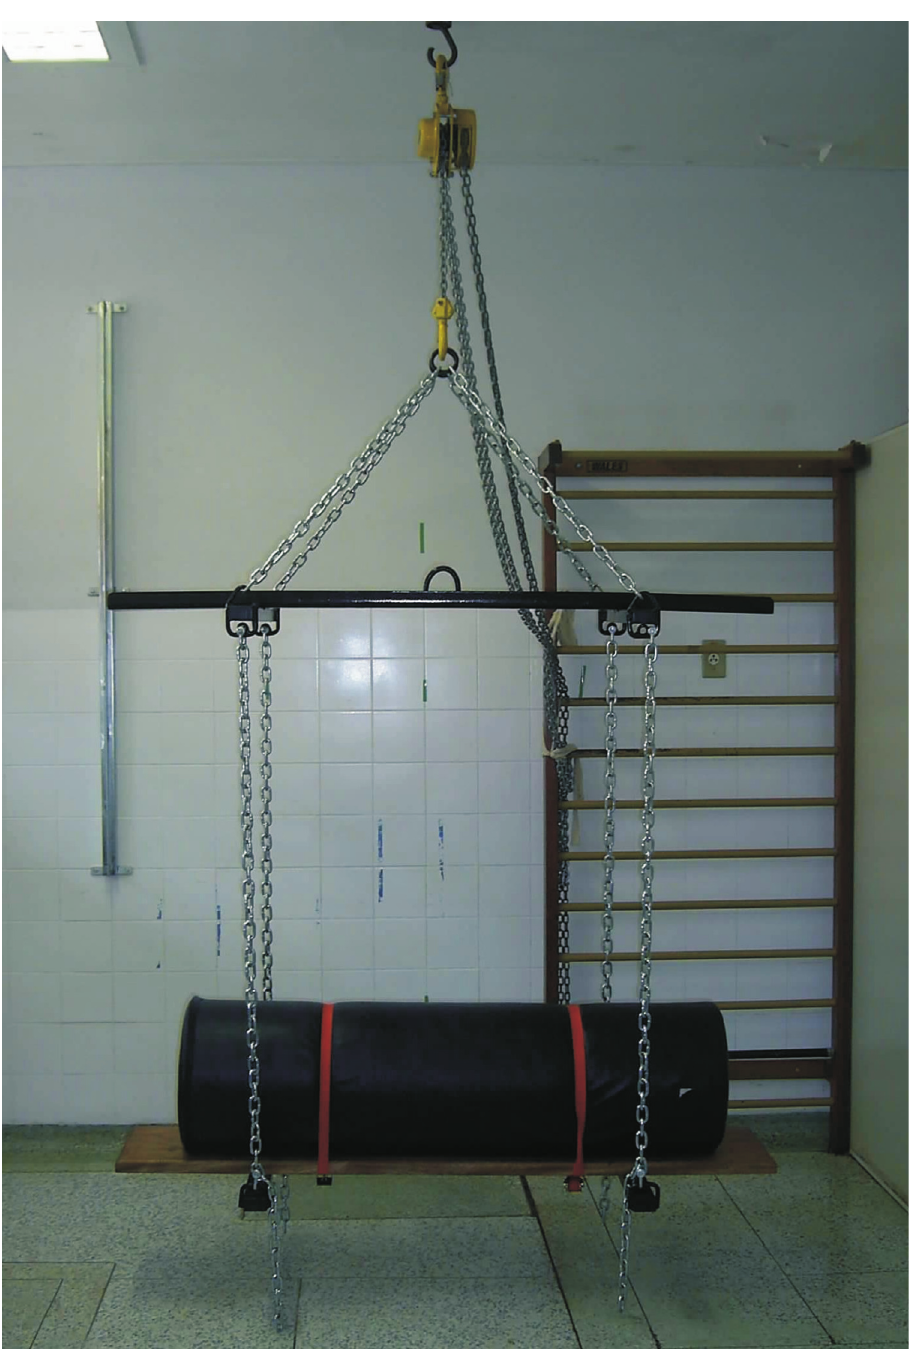
Figura 1 - Balanço suspenso por uma talha para suporte parcial de peso